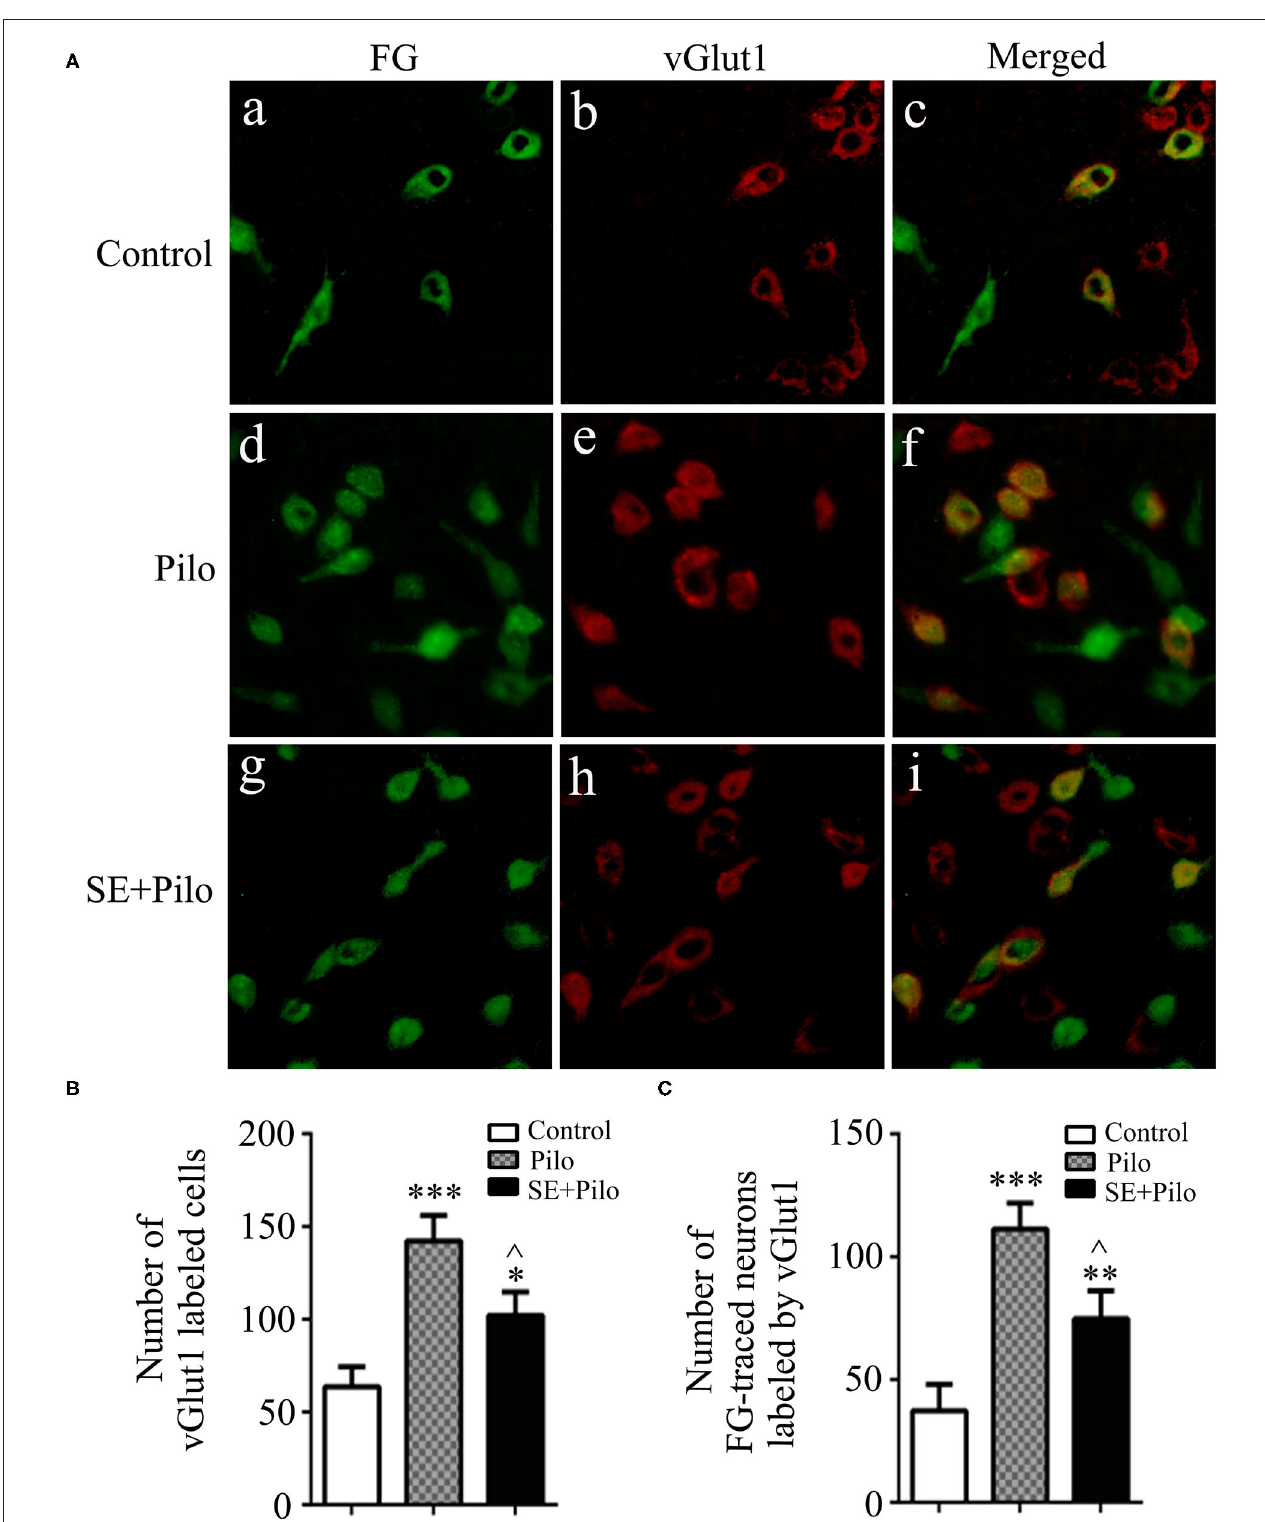
FIGURE 6 | Excitatory transmission activation induced by seizure stimulation in vlPAG is attenuated in chronic epilepsy. Coronal sections were immunostained for vGlut1 (red) and retrogradely traced with FG (green) (A) The mean number of vGlut1 immunoreactive neurons after a seizure stimulation either in naïve rats (meshy